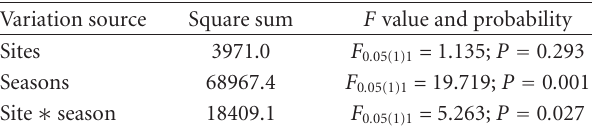
Table 3: Trophic niche breadth of Pogonomyrmex barbatus at two semiarid sites with contrasting productivities during the rainy and dry season. JR: Jard´ın rainy; JD: Jard´ın dry; LlR: Llano rainy; LlD: Llano dry.